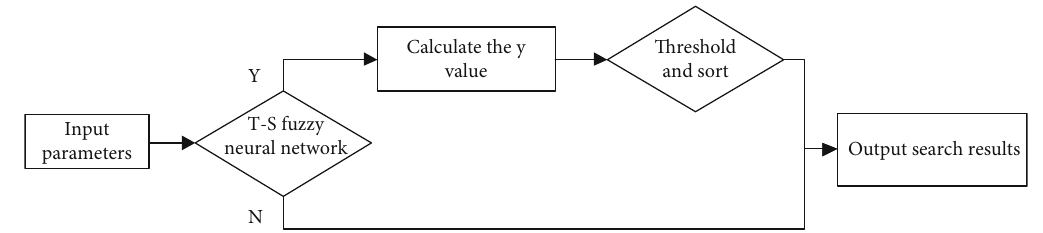
Figure 7: Data search fl ow chart of the database. Table 3: Fuzzy digital index of joint fi ssure. Criteria for the classi fi cation <